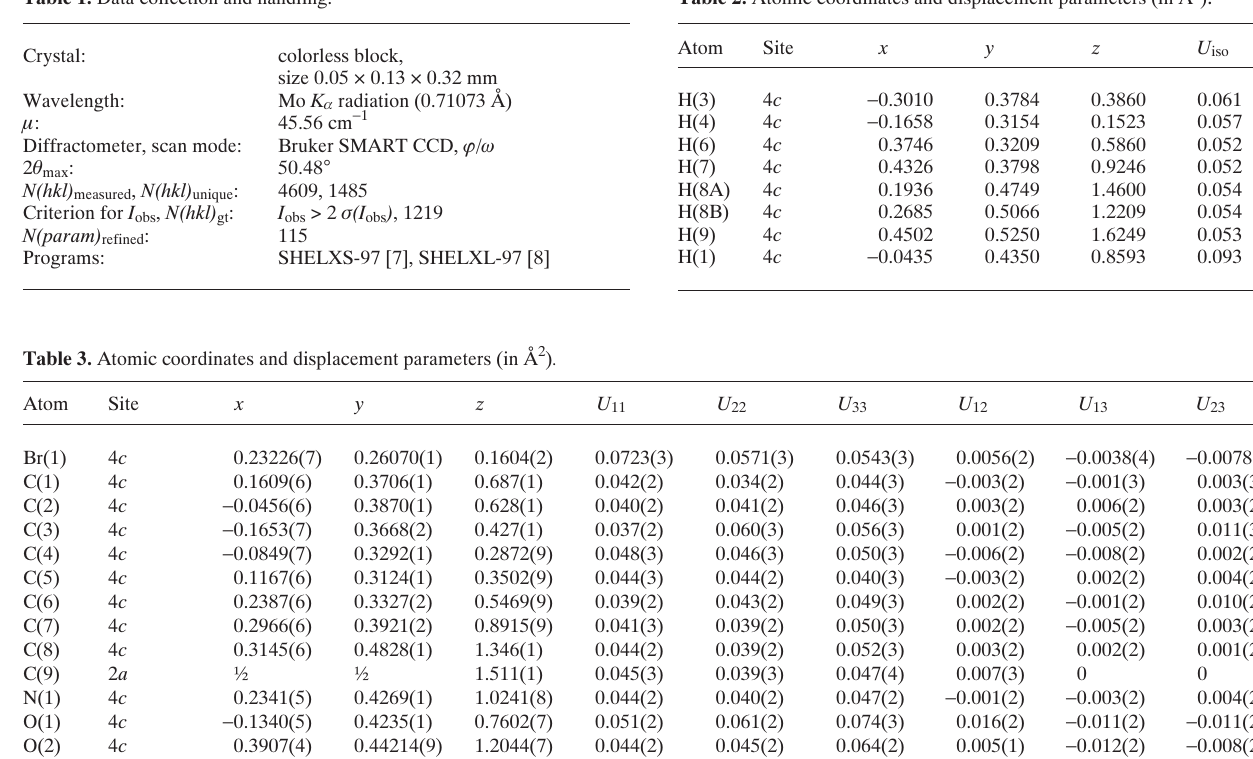
Table 2. Atomic coordinates and displacement parameters (in Å 2 ) . Table 1. Data collection and